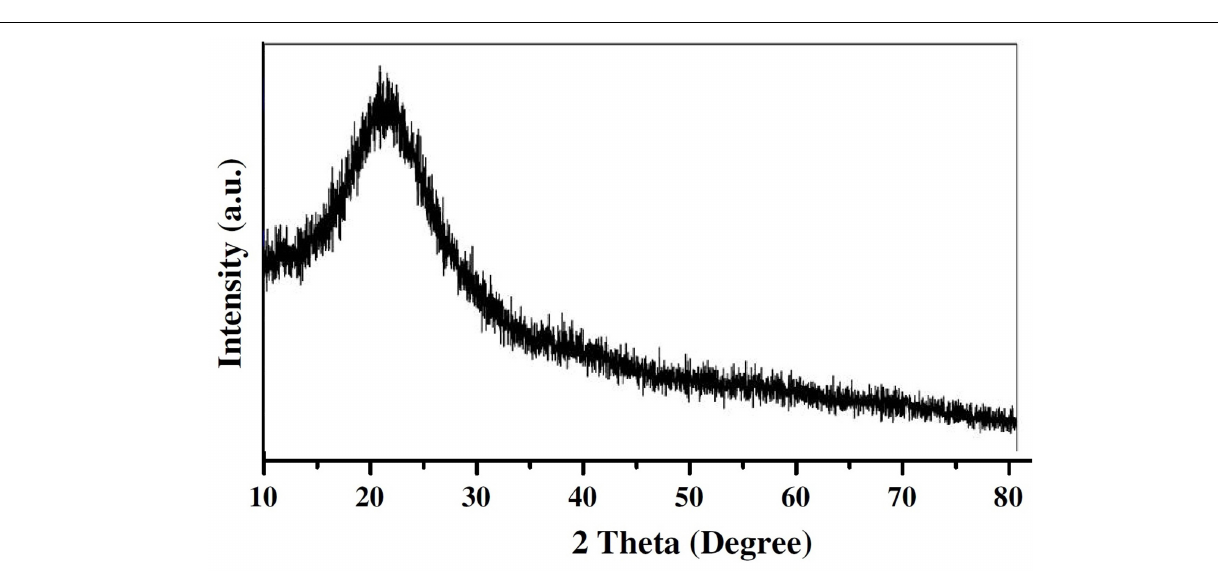
FIGURE 4 | X-ray diffraction pattern of Cordyceps fumosorosea -biochar